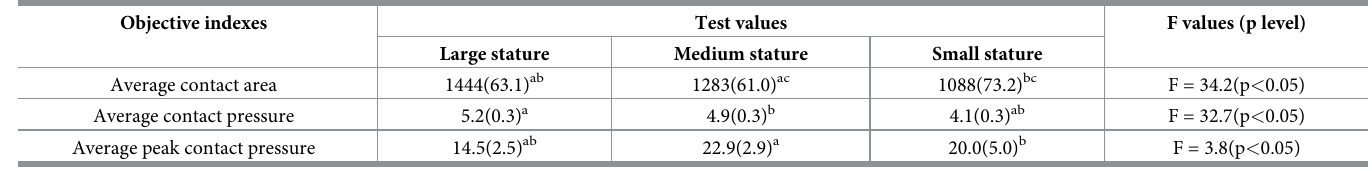
Table 5. Objective experimental test values at three stature under flat cushions (values in parentheses indicate a standard